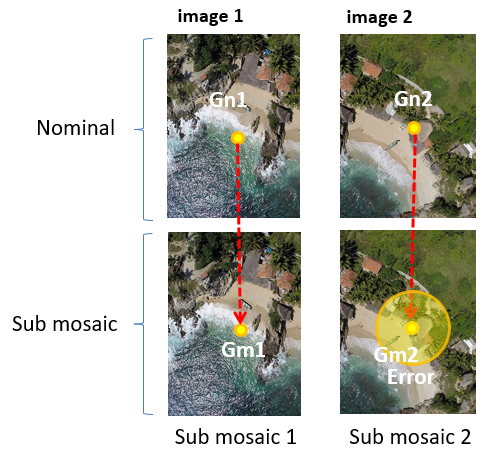
Figure 2. Euclidean distances between centroids